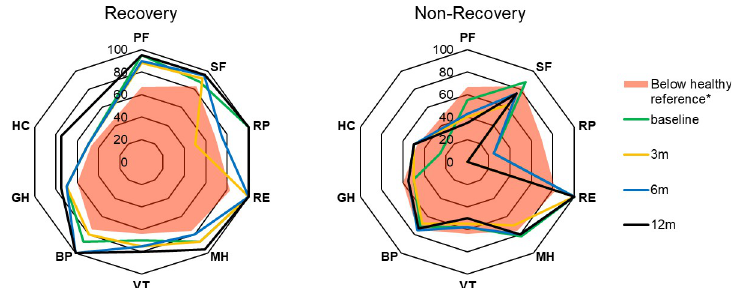
Fig 3. Health-related quality of life in R- and NR-group at baseline, three, six, and twelve months after admission, with visual indication of healthy reference value per domain of the RAND-36 questionnaire. Abbreviations: PF, Physical Functioning; SF, Social Functioning; RP, Role Physical; RE, Role Emotional; MH, Mental Health; VT, Vitality; BP, Bodily Pain; GH, General Health perception; HC, Health